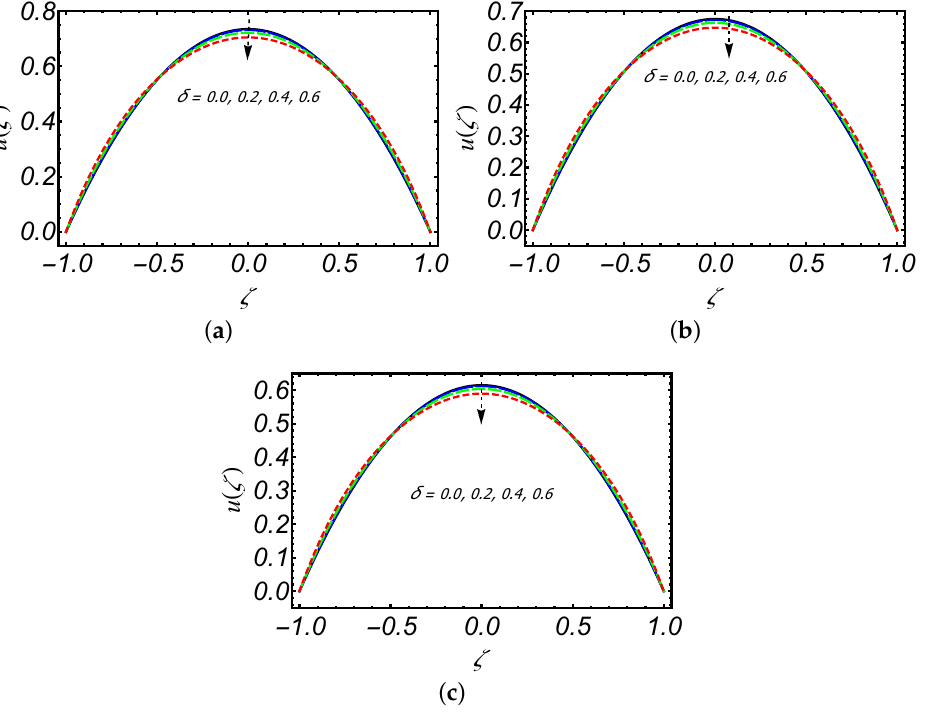
Figure 5. Behavior of u ( ζ ) with δ at ( a ) x = 0.1, ( b ) x = 0.5, ( c ) x = 0.9, when K = 0.2, φ =